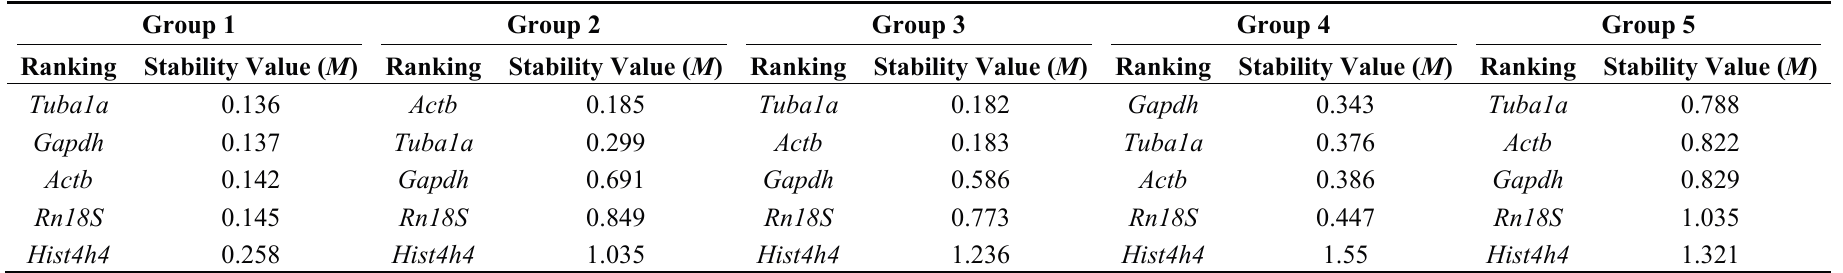
Table 3. Control genes ranked in order of their average expression stability. Reference genes are ranked according to the average expression stability value, M , as calculated by the geNorm statistical algorithm. The genes are ranked as most stable on the top. Group 1, branching morphogenesis (E11.5–E16.5); Group 2, differentiation, canalicular and saccular (E16.5–P5); Group 3, prenatal development (E11.5–E18.5); Group 4, postnatal development (P1–P28); Group 5, all stages.